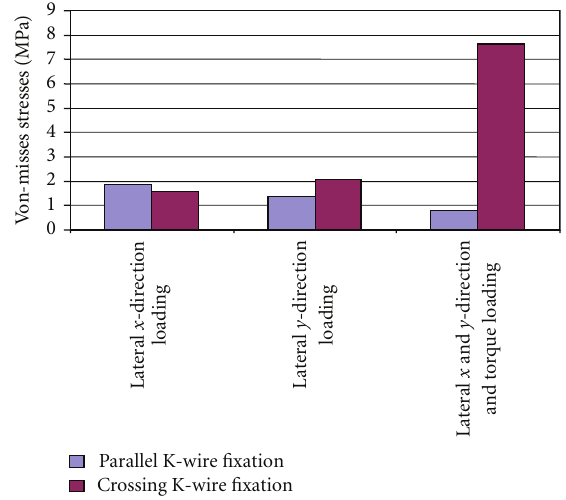
Figure 12: Predicted peak Von-Misses stresses for the three loading conditions of parallel and crossing K-wire fixation techniques at the bottom crack